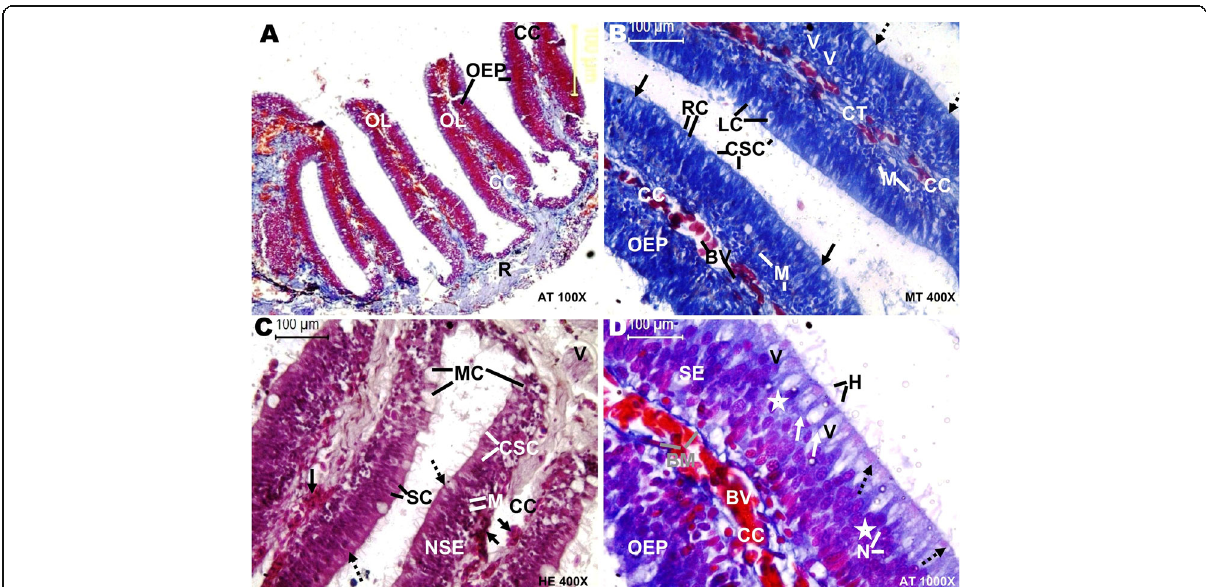
Fig. 2 Histomicroscopy of olfactory organ in E. vacha stained with Azan Trichrome (AT), Mallory ’ s Triple (MT), and Delafield ’ s hematoxylin-eosin (HE) stain. A Olfactory lamellae (OL) connected with raphe (R) exhibit compact olfactory epithelium (OEP) on both side of midline central core (CC). B OEP contains primary receptor cells (RC), rod receptor cells (solid arrows), labyrinth cells (LC), mast cells (M), basal cells (arrow heads), and ciliated (CSC) and nonciliated supporting cells (SC) (broken arrows). CC provided with blood vessels (BV) and connective tissue fibers (CT). C Basal portion of lamella shows nonsensory epithelium (NSE) with secretory mucous cells (MC), labyrinth cells (broken arrows), M, SC, CSC. CC contains BV (solid arrows). Arrow head marks fila olfactoria. D Part of sensory epithelium (SE) shows primary receptor cells (solid arrows) with nuclei (N) and apical hairs (H), rod receptor cell (asterisks), and microvillous cells (broken arrows). Basement membrane (BM) separates OEP from CC which contains cluster of BV. Arrow heads indicate bipolar